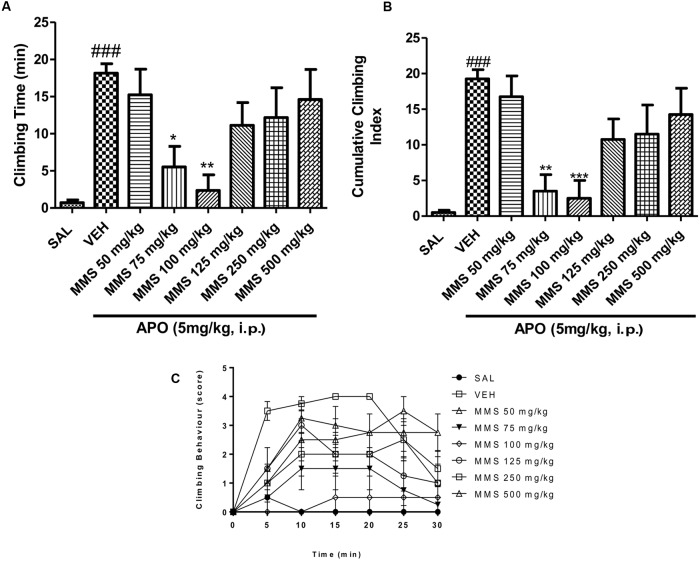
Effect of methanolic extract of Mitragyna speciosa (MMS) (50–500 mg/kg, p.o.) on cage climbing behavior and cage climbing time induced by apomorphine (APO 5 mg/kg, i.p.) in mice. (A) Total time spent on the wall of the cage. (B) The cumulative climbing scores were measured for 30 min after apomorphine administration. (C) The climbing behavior was scored at 5 min interval after apomorphine treatment. Each point represents the mean ± SEM from the scores obtained from eight animals. Statistical significance: ###p < 0.001 compared with the saline control group; ∗p < 0.05, ∗∗p < 0.01, ∗∗∗p < 0.001 compared with the vehicle control (VEH) group.